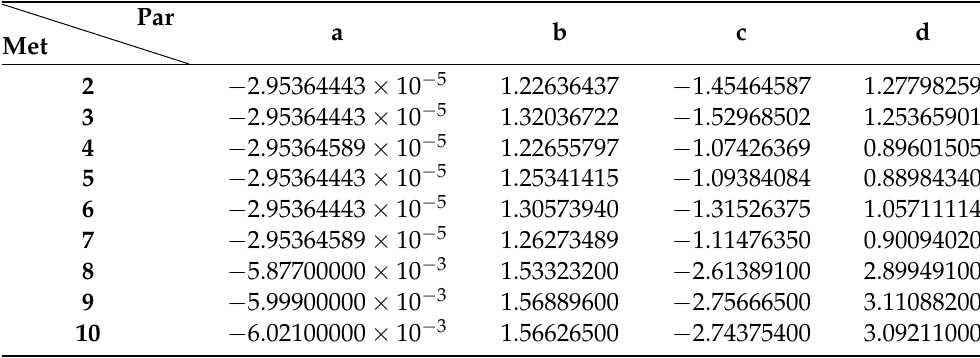
Table 1. Empirical coefficients a–d for the DHR conversion used in Equation (1) for each Meteosat platform.